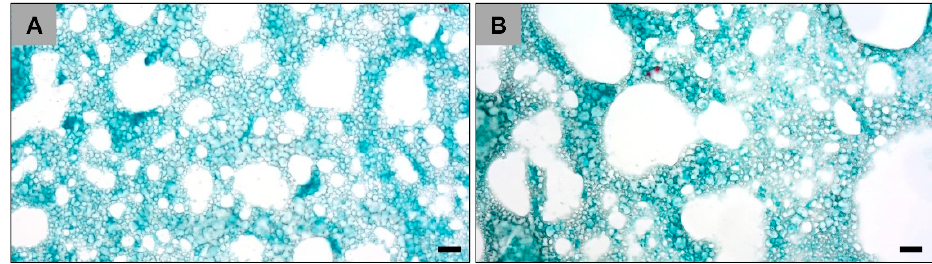
Figure 2. Exemplary microscopic images of the vaterite-loaded hydrogels in vivo within the implant bed centers at day 15 post implantation. ( A ) VH-A hydrogel. ( B ) VH-B hydrogel. (Movat Pentachrome stainings, magnification = 400 × and scalebars = 20 µm).